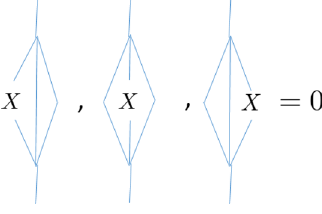
Figure 54. Single X insertion.